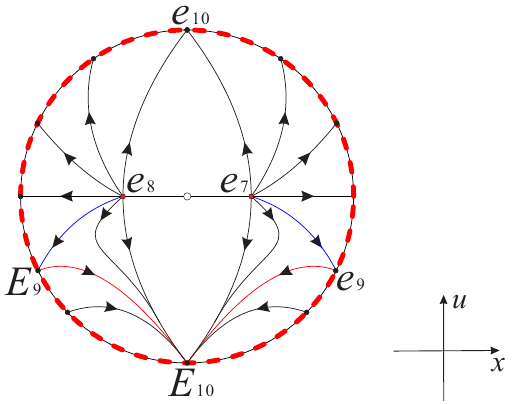
Figure 9. The global phase portrait of system (16) on the invariant surface f + ( x , z , u ) = 0 restricted to the region u ≥ z . Here E 9 is the symmetric point of e 9 with respect to the axis x = 0, and E 10 is the diametrically opposite equilibrium point of e 10 at infinity.